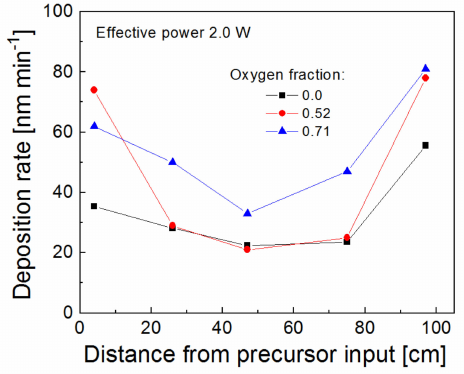
Figure 3. Deposition rate along the tubular reactor for plasma nanocoatings deposited from the TVS / O 2 mixture at an e ff ective power of 2.0 W and di ff erent oxygen fractions.